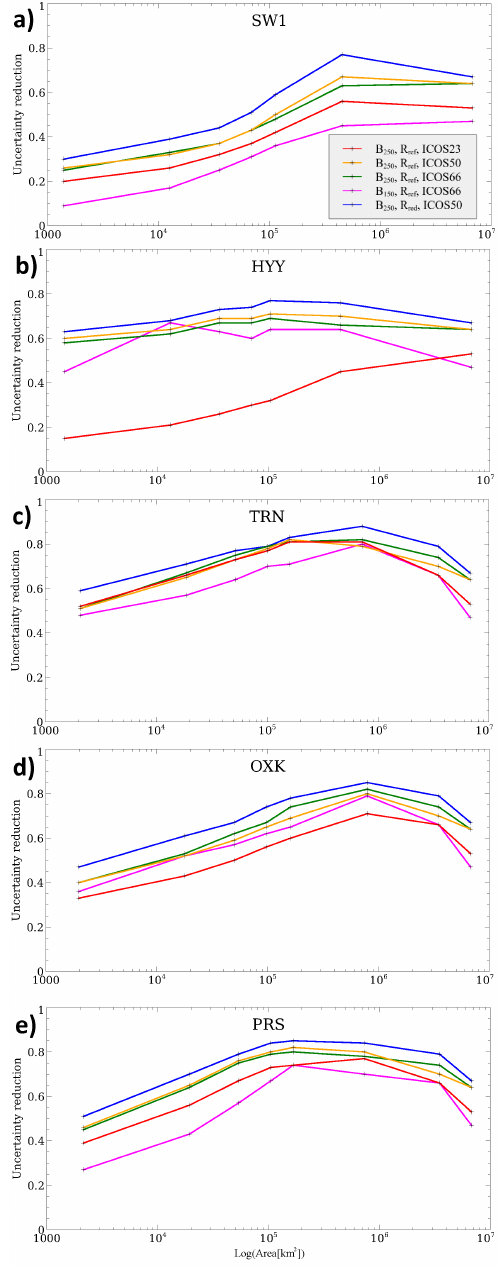
Figure 9. Uncertainty reduction (theoretically comprised between 0 and 1) for a 2-week-mean NEE for July 2007 as a function of the size (in logarithmic scale) of the spatial averaging area (same as for Fig. 5) centered on (a) SW1, (b) HYY, (c) TRN, (d) OXK, and (e) PRS. Red, orange and green lines: results with the reference configuration of the inversion using ICOS23, ICOS50 and ICOS66, respectively; blue: results when using ICOS50 and the inversion configuration with R = R red ; pink: results when using ICOS66 and the inversion configuration with B = B 150 . The results of uncer- tainty reduction for the whole European domain are included sys- tematically. The results for the western European domain defined in Fig. 1c are included on curves corresponding to sites, which are located in this domain (TRN, PRS and